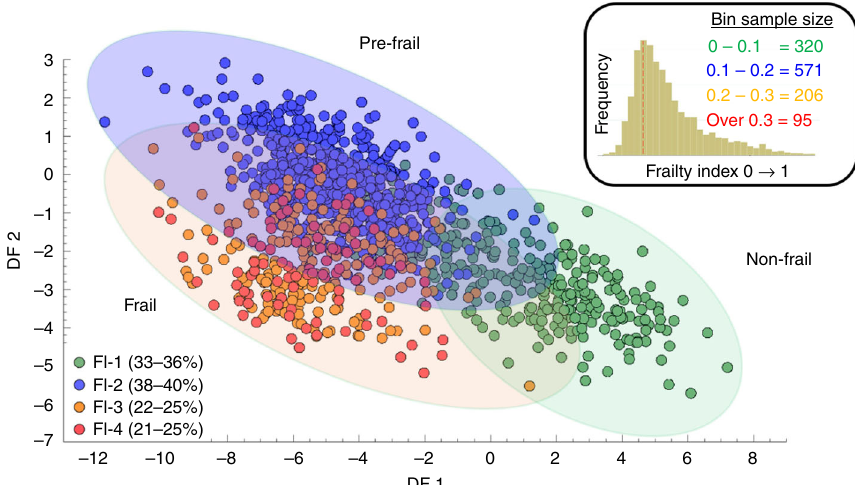
Fig. 2 PC-DFA of serum metabolite data strati fi ed over the frailty index distribution. Principal component discriminant function analysis (PC-DFA) carried out on serum metabolite pro fi ling data from 1191 subjects within wave 4 of ELSA. Data were log 2 transformed and strati fi ed in to groups determined by Rockwood Frailty Index value. The results were cross validated by bootstrapping (10,000 iterations) and indicate two clear planes of separation along the 0.1 – 0.2 axis and the 0.2 – 0.3 axis. This data correlates with observations that directly stratify clinical assessment over the frailty index indicating three distinct clinical phenotypes 55 . Green circle = Frailty Index 0 – 0.1, Blue circle — Frailty Index 0.1 – 0.2, Orange circle = Frailty Index 0.2 – 0.3, Red circle = Frailty